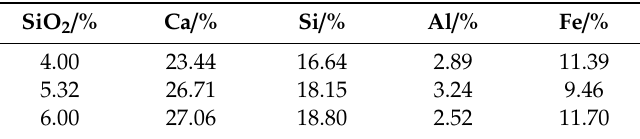
Table 3. E ff ects of SiO 2 content on composition of Table 3. Effects of SiO 2 content on composition of silicate.